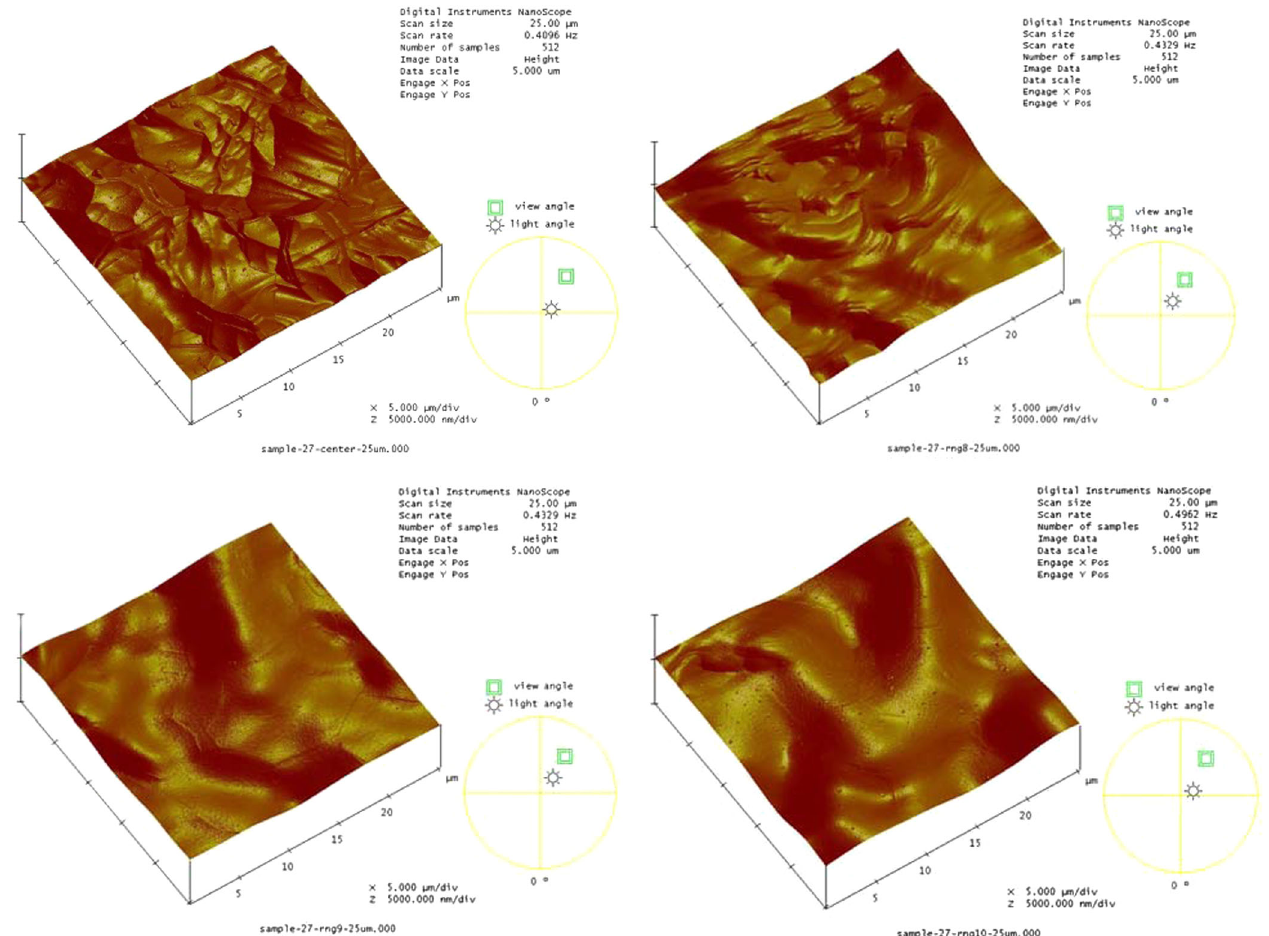
FIG. 5. AFM images of the niobium surface after laser treatment, with 34 pulses overlapped and fluence indicated. Top left, BCP surface without laser treatment; top right, 1 . 13 J = cm 2 ; lower left, 0 . 90 J = cm 2 ; lower right, 0 . 68 J = cm 2 . Scan area 25 μ m × 25 μ m. Horizontal scale: 5 μ m per division. Vertical scale: 0 . 5 μ m per division.